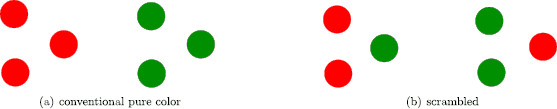
Learned images for two-color three-dot experiments